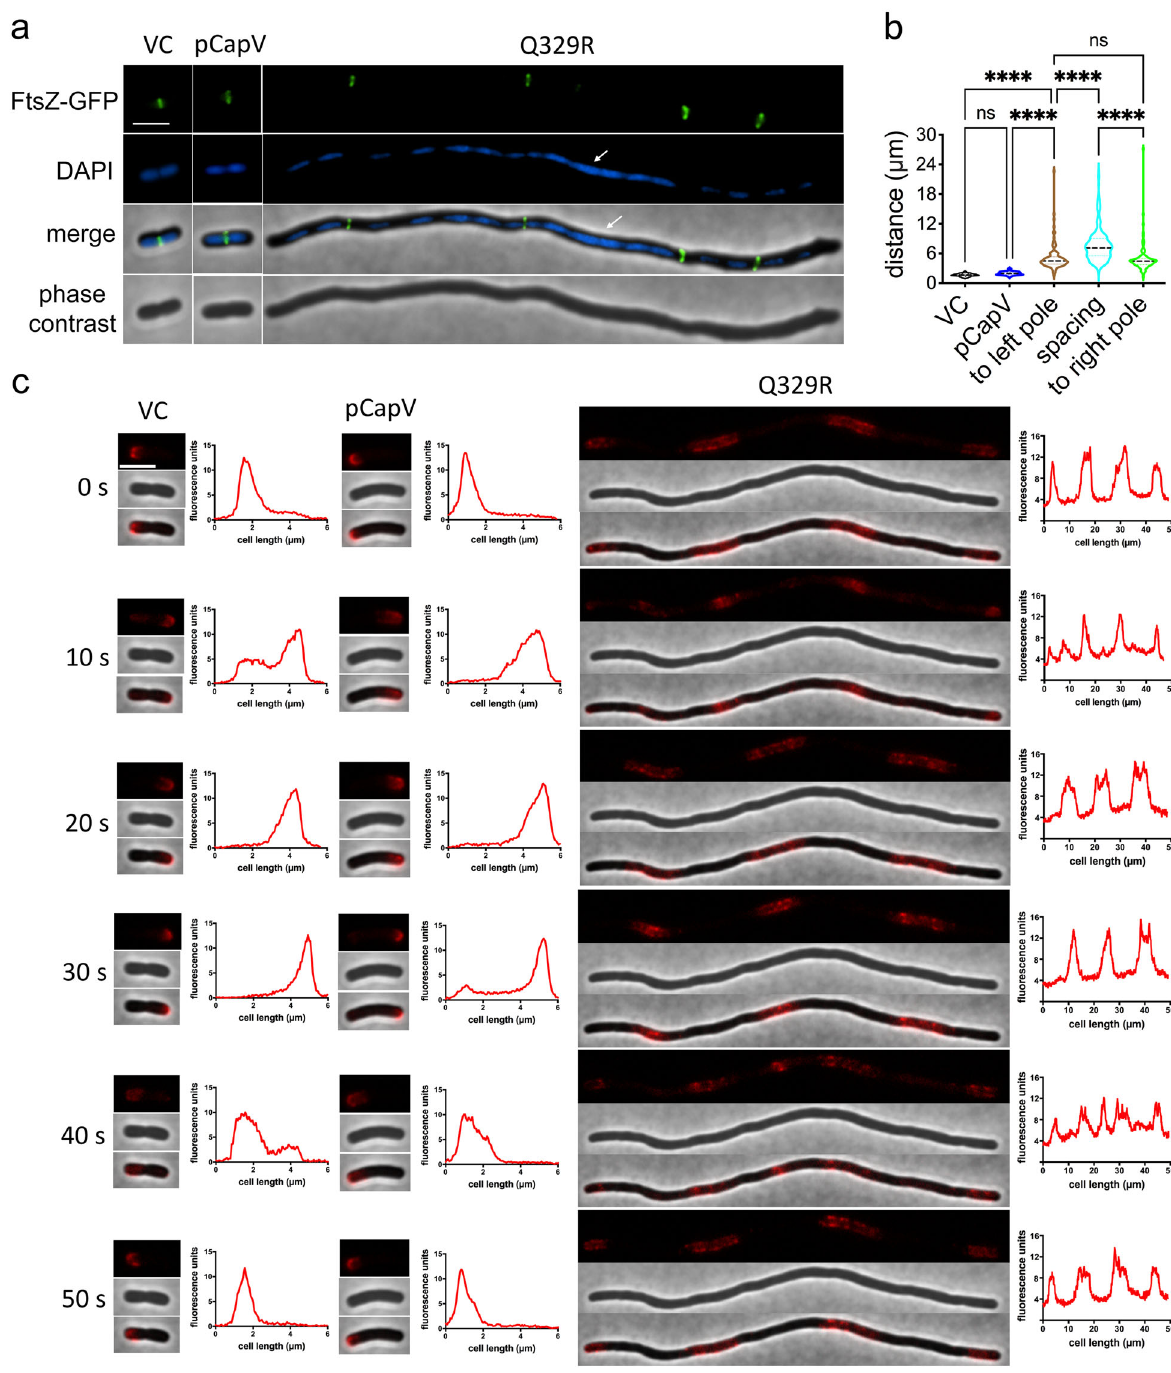
Fig. 5 Cell division and chromosomal segregation, but not FtsZ-ring formation, is impaired in fi lamentous cells. a Phase-contrast and fl uorescence images of FtsZ-GFP expressing cells ( E. coli MG1655 derivative BS001 harboring vector control (VC), pCapV and pCapV were cultured in TB medium at 37 °C for 4 h, stained with DAPI, and assessed immediately under fl uorescence microscopy. Large fragments of unsegregated nucleoids are indicated by white arrows. Bar, 3 µm. b Quanti fi cation of the average distance between two adjacent FtsZ rings upon overexpression of CapV and CapV Q329R , refers to Table 1. c Time-lapse analysis of mCherry-MinC expressing cells ( E. coli MG1655 derivative PB318 harboring VC, pCapV and pCapV Q329R ). A representative elongated cell is displayed. Graphs on the right of fl uorescence images display the line pro fi les of fl uorescent signals emanating from the cell. Arbitrary fl uorescent units are obtained, analyzed by the Fiji ImageJ 1.8.0 software, and are plotted on the y axis; cell length (in µm) is plotted on the x axis. Bar, 3 µm. VC = pBAD28. pCapV = CapV cloned in pBAD28; Q329R = CapV Q329R cloned in